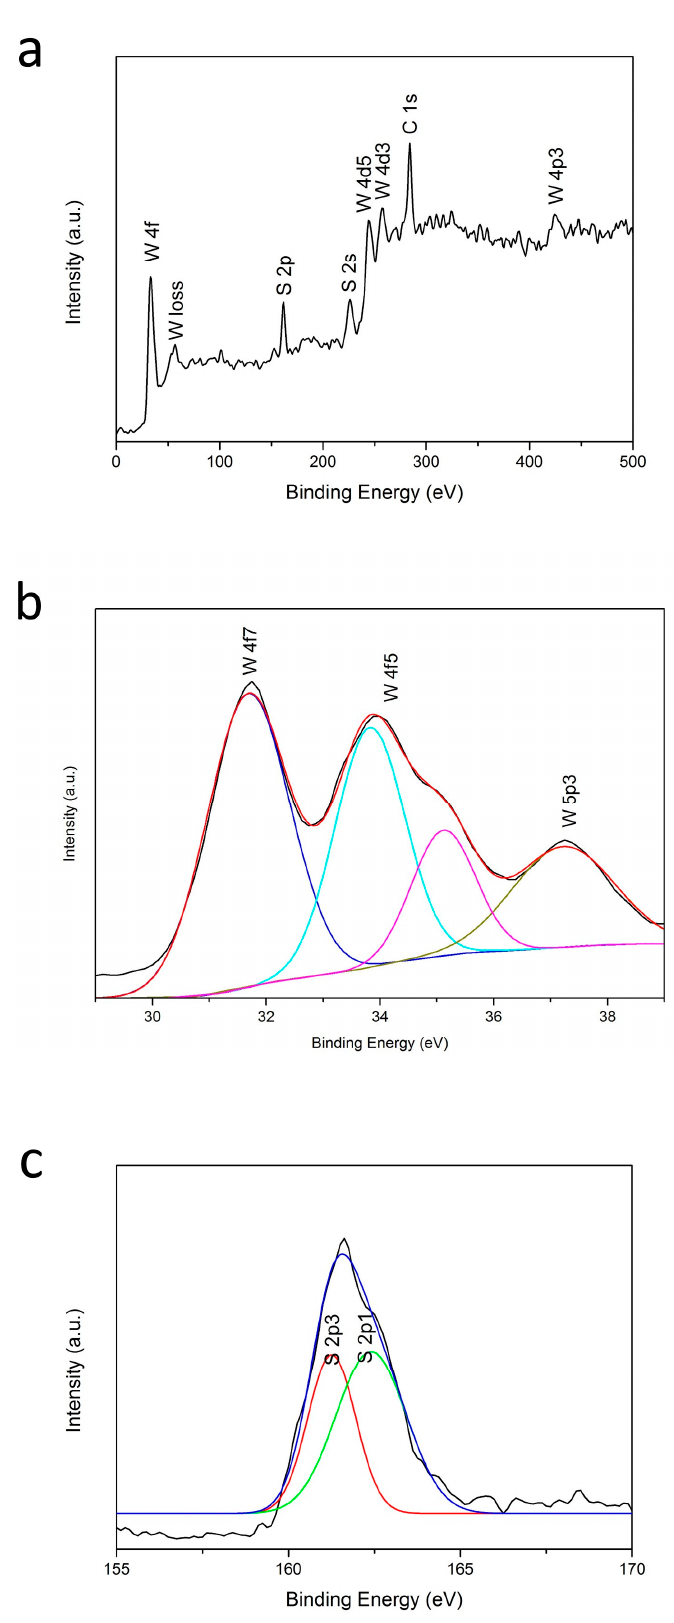
Figure 3. XPS spectra of WS 2 QDs. ( a ) Survey scan; ( b ) W4f; and ( c ) S2p peak, respectively.